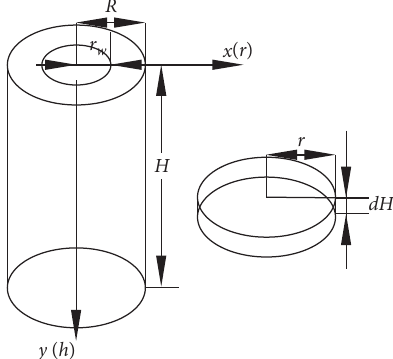
Figure 2: Schematic diagram of the dehydration model of total tailings filling